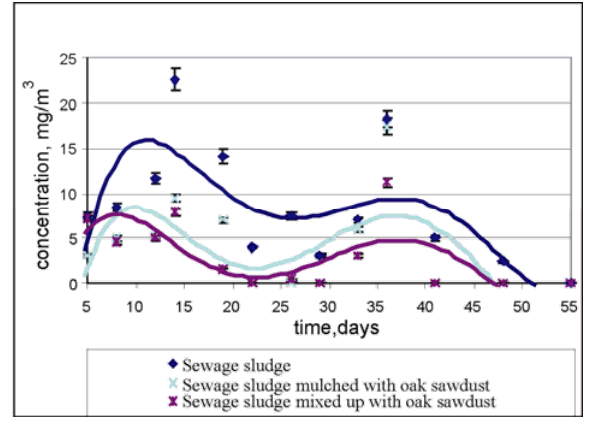
Fig. 17. VOC emissions during composting sewage sludge with oak sawdust